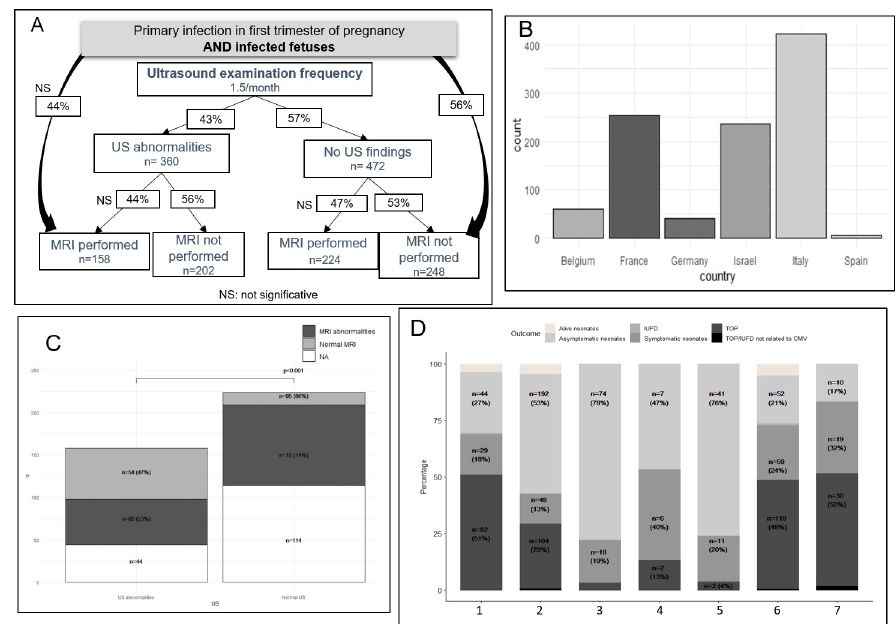
Fig 4. Management for population 2 (women with infected fetuses). A. Population 2 flowchart with radiological interventions (US and MRI). MRI performing is described according to US abnormalities or not. B. Repartition of population 2 according to their country of study. C. MRI findings according to US abnormalities. D. Pregnancy outcome (alive neonate–symptoms not reported, asymptomatic neonate, IUFD, symptomatic neonate, TOP, TOP/ IUFD not related to cCMV) according to radiological findings (1 to 7). 1: presence of US findings? Data not reported; 2: Normal US; 3: Normal US and normal MRI; 4: Normal US and MRI abnormalities; 5: US abnormalities and normal MRI; 6: US abnormalities; 7: US abnormalities and MRI abnormalities. NA: data not reported; US: ultrasound; MRI: magnetic resonance imaging; HIG: hyperimmunoglobulin; RCT: randomized controlled trial; IUFD: intra uterine fetal